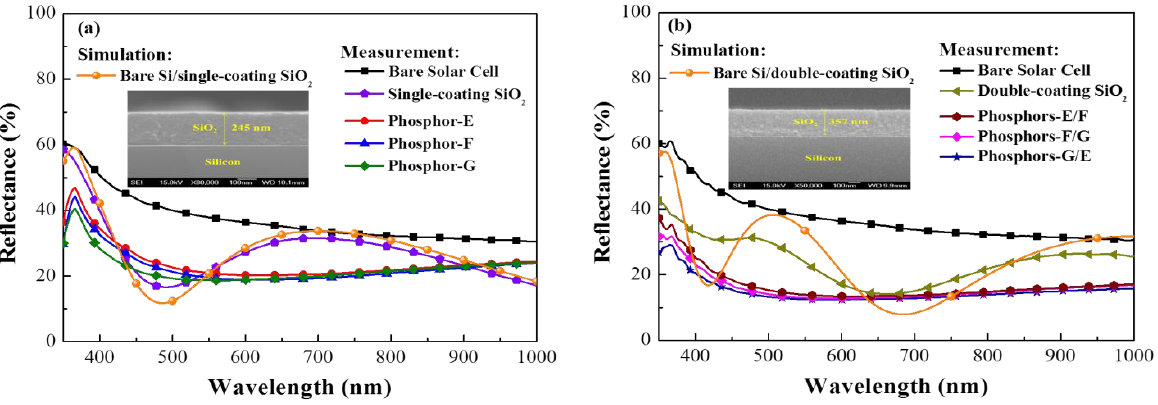
Figure 7. Measured and simulated reflectance of all cells in this study: ( a ) single-coating with single phosphor; ( b ) double-coating with two phosphors. phosphor; ( b ) double-coating with two